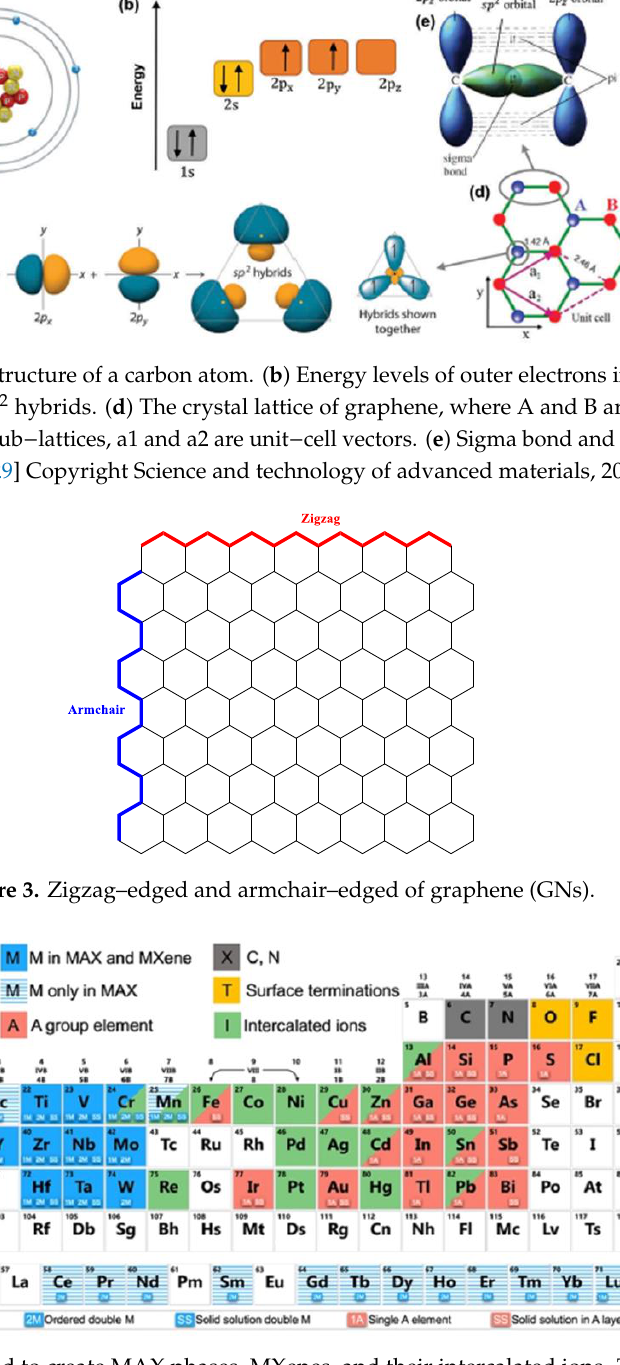
Figure 4. Elements used to create MAX phases, MXenes, and their intercalated ions. The A elements are denoted by a red background and are used to synthesize MAX phases that can possibly be utilized to make MXenes. The elements denoted by a green background, have been intercalated into MXenes (to date) and the symbols are at the bottom, 1M and 1A designate the formation of a single (pure) transition metal and A element MAX phase (and MXene). Solid solutions are indicated by an SS in transition metal atomic planes (blue) or A element planes (red); and 2M indicates the formation of an ordered double-transition metal MAX phase or MXene (in-plane or out-of-plane). The MAX phase elements denoted by blue striped background have not yet been used to synthesis MXene (Figure 5) [32] Copyright American Chemical Society, 2019.